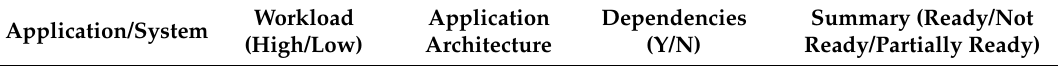
Table 1. Cloud readiness